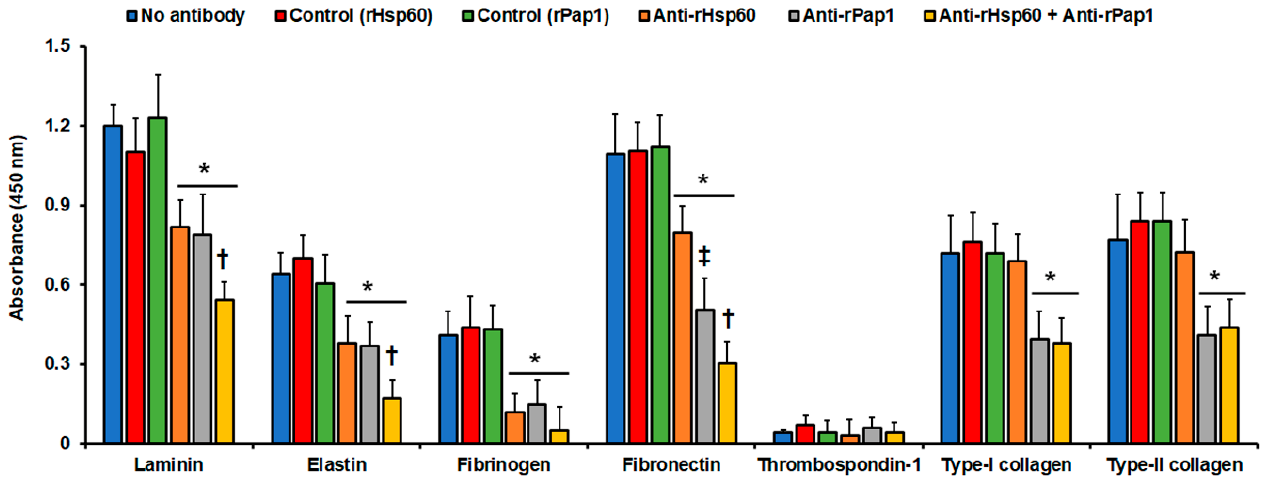
Figure 3. Adhesion of Sporothrix schenckii yeast-like cells to immobilized extracellular matrix proteins. The extracellular matrix proteins were immobilized in the 96-well plates and used in ELISA-based analyses. Yeast-like cells were added to the plates, nonadherent cells were washed, and cells bound to extracellular matrix proteins were detected with anti-rGp70 antibodies and peroxidase-conjugated anti-rabbit IgG. No antibody, cells were pre-incubated with PBS; Control (rHsp60) and Control (rPap1), cells were pre-incubated with pre-immune sera; anti-rHsp60, cells were pre-incubated with polyclonal anti-rHsp60 antibodies; and anti-rPap1, cells were pre-incubated with polyclonal anti-rPap1. Results are means ± SD of three independent experiments performed by duplicate. * p < 0.05 when compared to cells pre-incubated with PBS. † p < 0.05 when compared to cells pre-incubated with anti-rHsp60 or rPap1. ‡ p < 0.05 when compared to cells pre-incubated with anti-rHsp60.